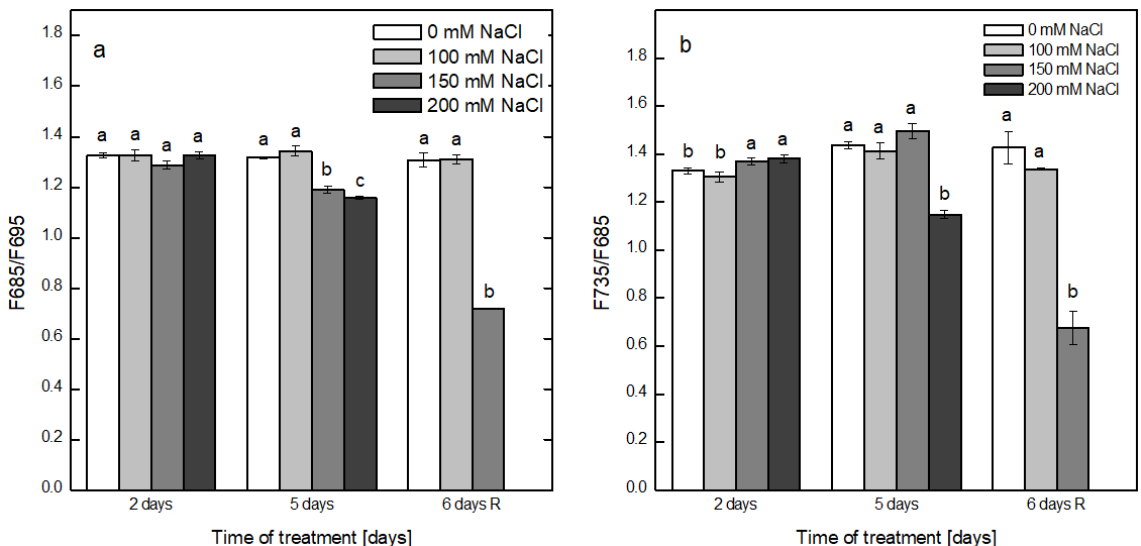
Figure 8. Alterations in the fluorescence F685/F695 ( a ) and F735/F685 ratios ( b ) in the thylakoid membranes isolated from the non-treated plants (0 mM NaCl) and pea plants treated with NaCl (100, 150 or 200 mM) for 2 and 5 days and after recovery (6 days R). Ratios were calculated from the fluorescence emission spectra subjected to excitation with 436 nm. Mean values ± SE were calculated based on three independent experiments with two parallel samples for each time point ( n = 6). Different letters indicate significant differences between values for the control plants (0 mM NaCl) and plants treated with increased concentrations of NaCl at p < 0.05 for the respective period of the experimental setup (2 and 5 days of treatment and the recovery period).